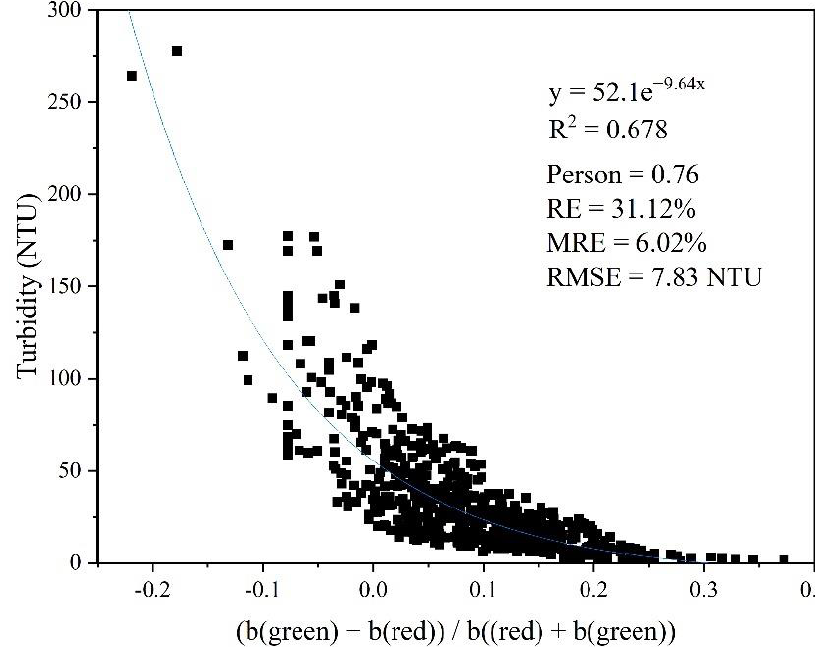
Figure 6. Turbidity inversion model.